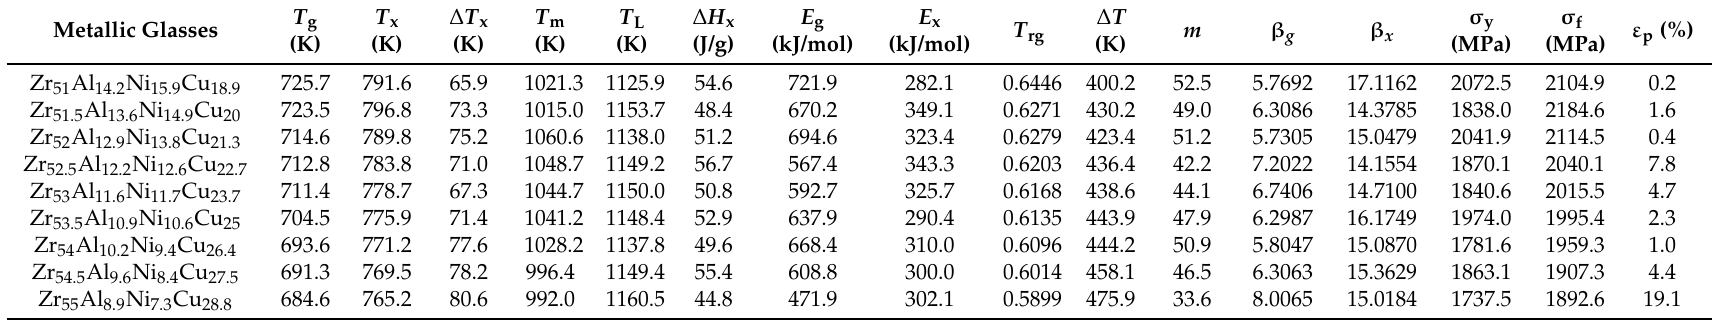
Table 1. Glass transition temperature T g , crystallization temperature T x , supercooled liquid region ∆ T x , solidus temperature T m , liquidus temperature T L , reduced glass transition temperature T rg = T g / T L , and ∆ T = T L ´ T g at a heating rate of 30 K ¨ min ´ 1 , crystallization enthalpy ∆ H x , activation energy for T g ( E g ), activation energy for T x ( E x ), sensitivity of T g and T x to heating rate ( β g and β x ), fragility index m , yield strength σ y , fracture strength σ f , and plastic strain ε p